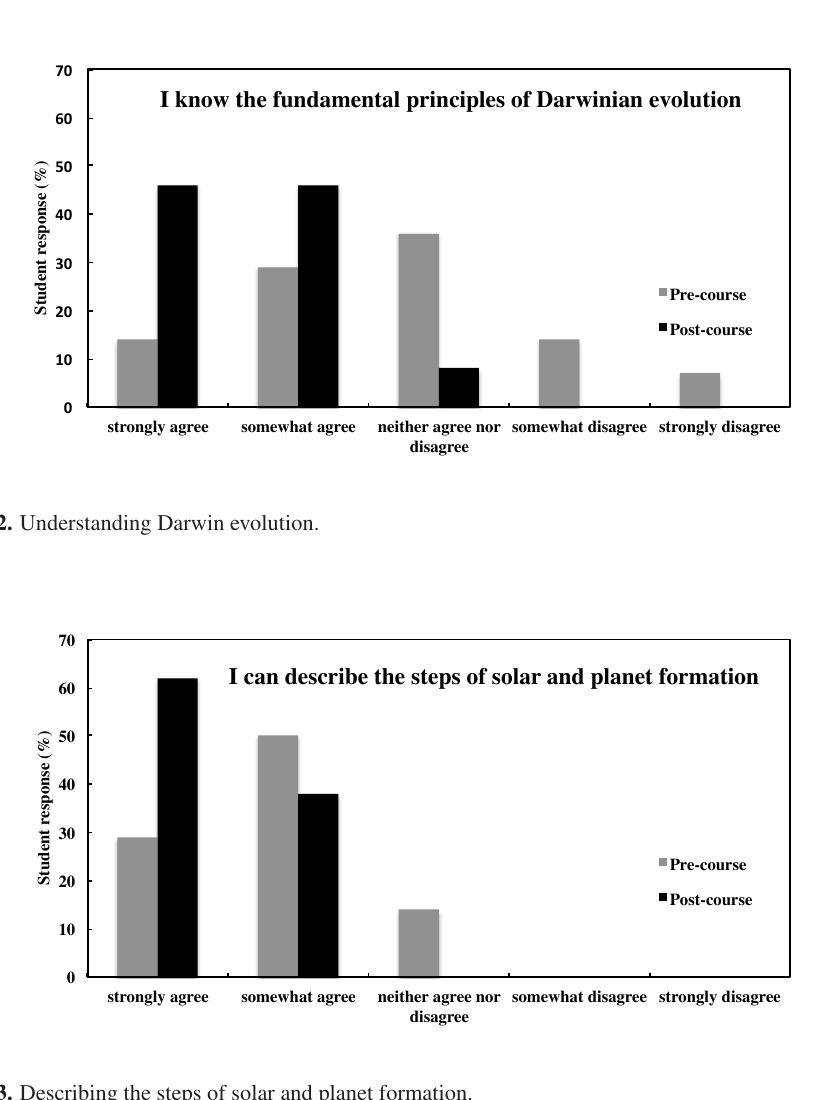
Figure 3. Describing the steps of solar and planet